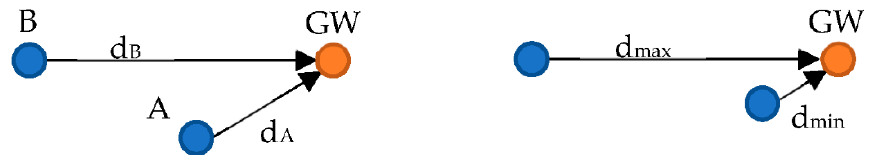
Figure 4. Distances ( left ) and constraints ( right ) for applying the distance criterion.